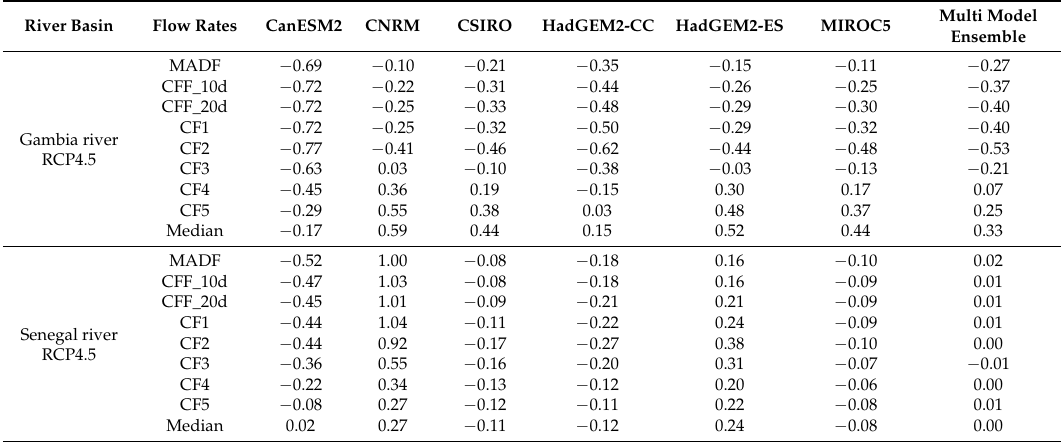
Table A1. Relative change in characteristic high flow for different used GCM under RCP4.5.